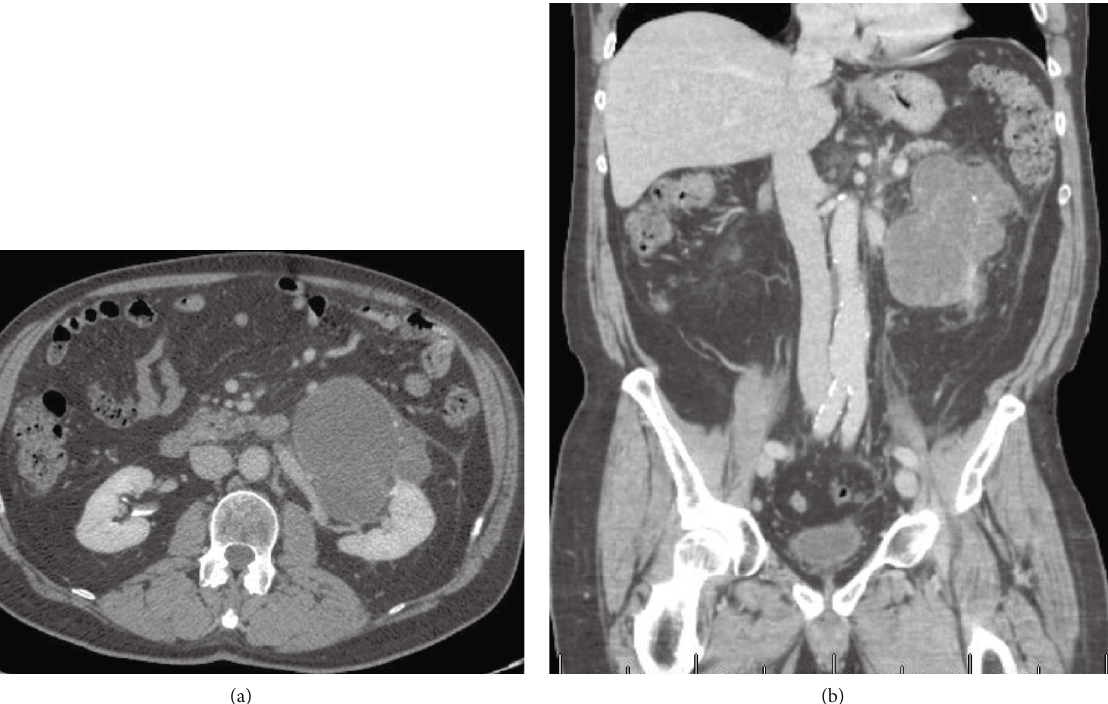
Figure 3: CT imaging after nivolumab/ipilimumab treatment: (a) axial imaging demonstrating signi fi cant decrease in size of the renal mass;